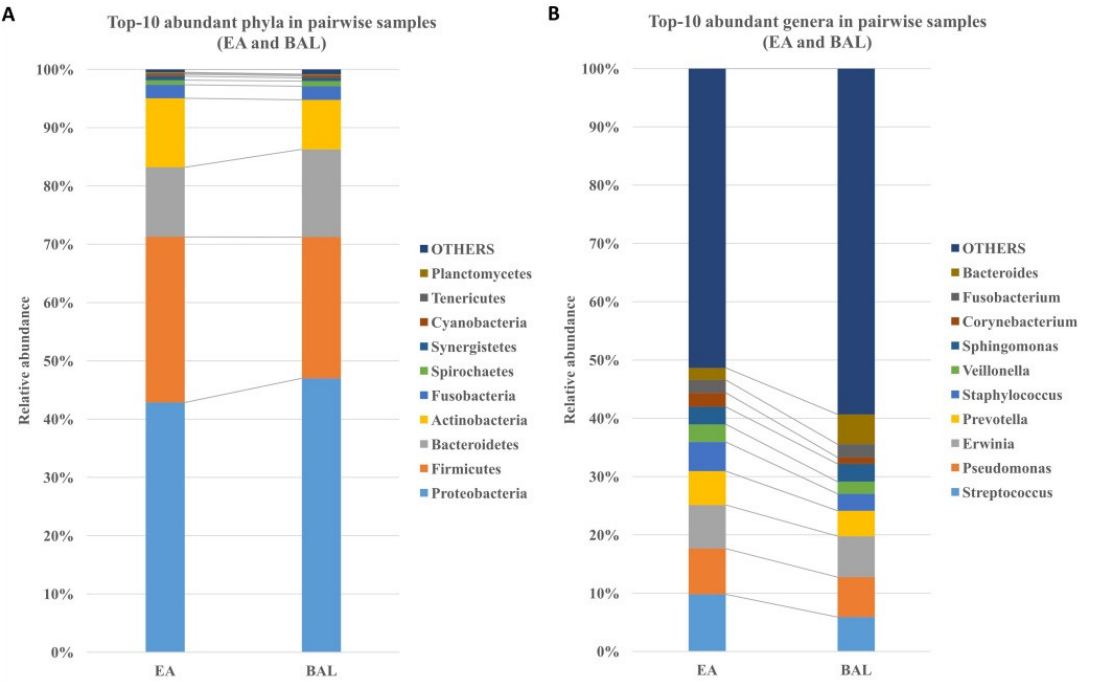
Figure 2. Relative abundance of the major microbiota in each pairwise EA and BAL samples. ( A ) Top 10 abundant phyla. ( B ) Top 10 abundant genera.